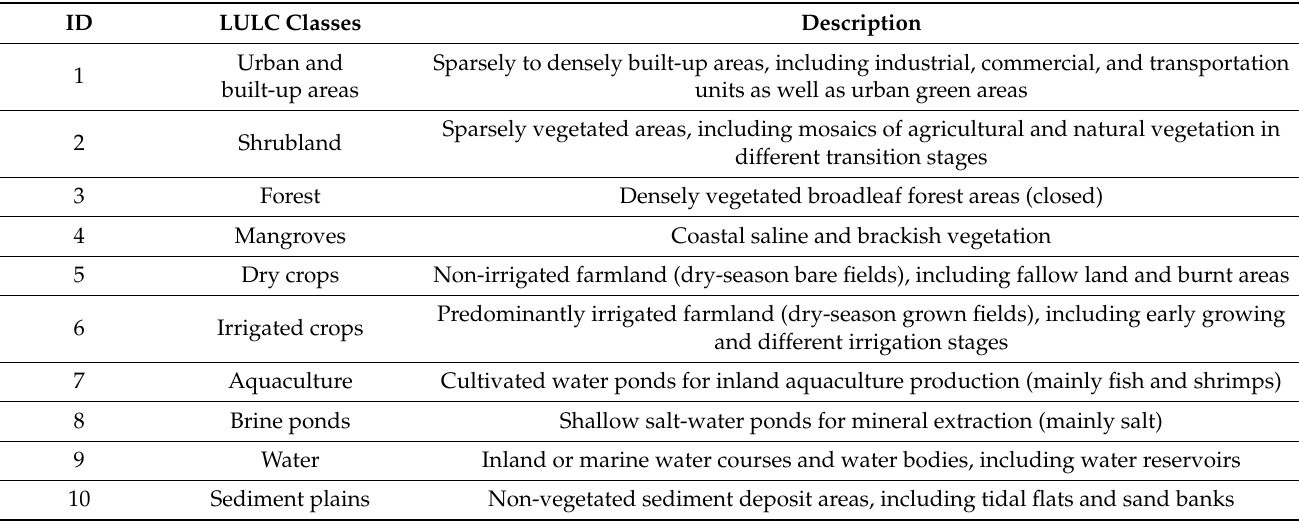
Table 2. Classification scheme including major landscape